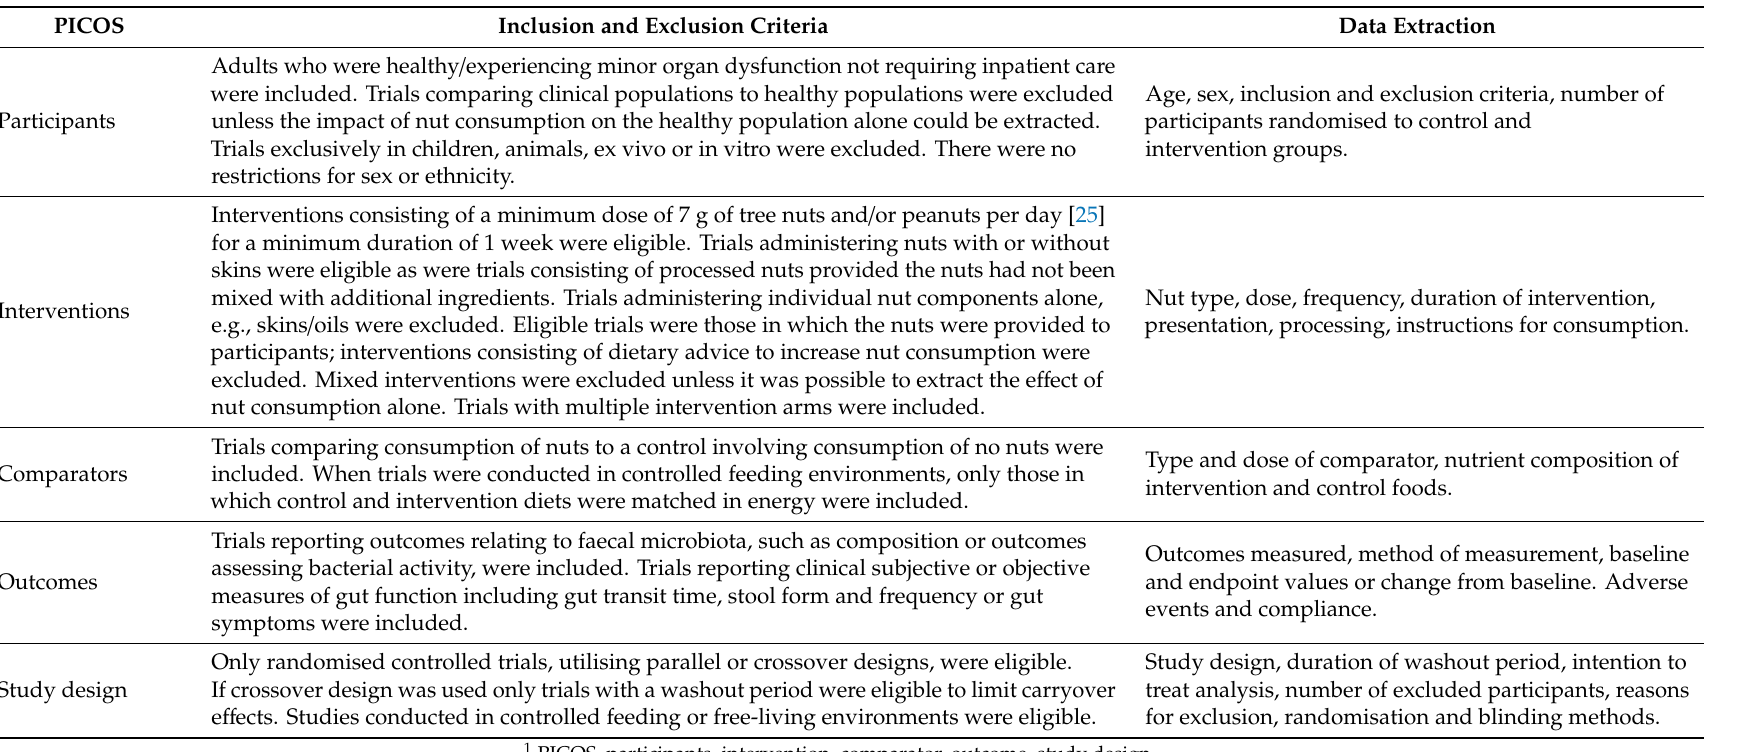
Table 1. Inclusion and exclusion criteria and data extracted for eligible studies using the PICOS 1